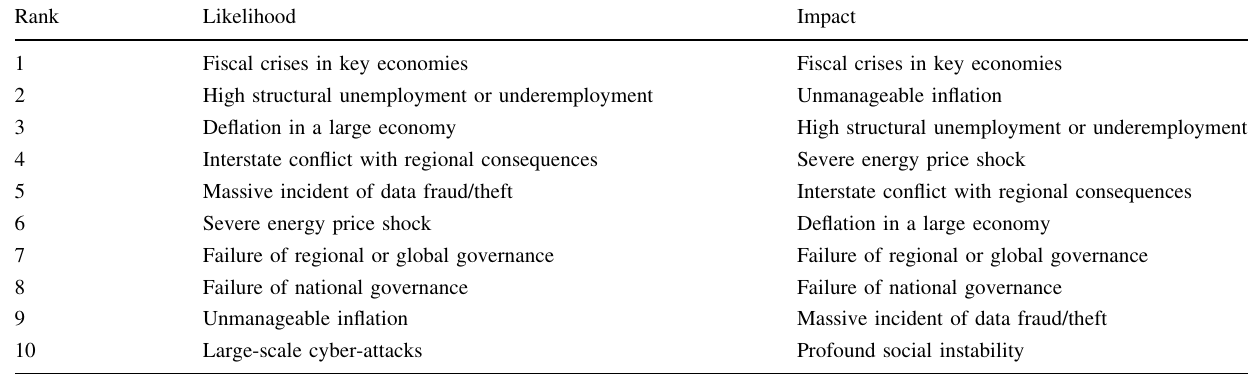
Table 3 Top 10 global risks in terms of likelihoods and impacts for the sample small and medium enterprises in Turkey Rank